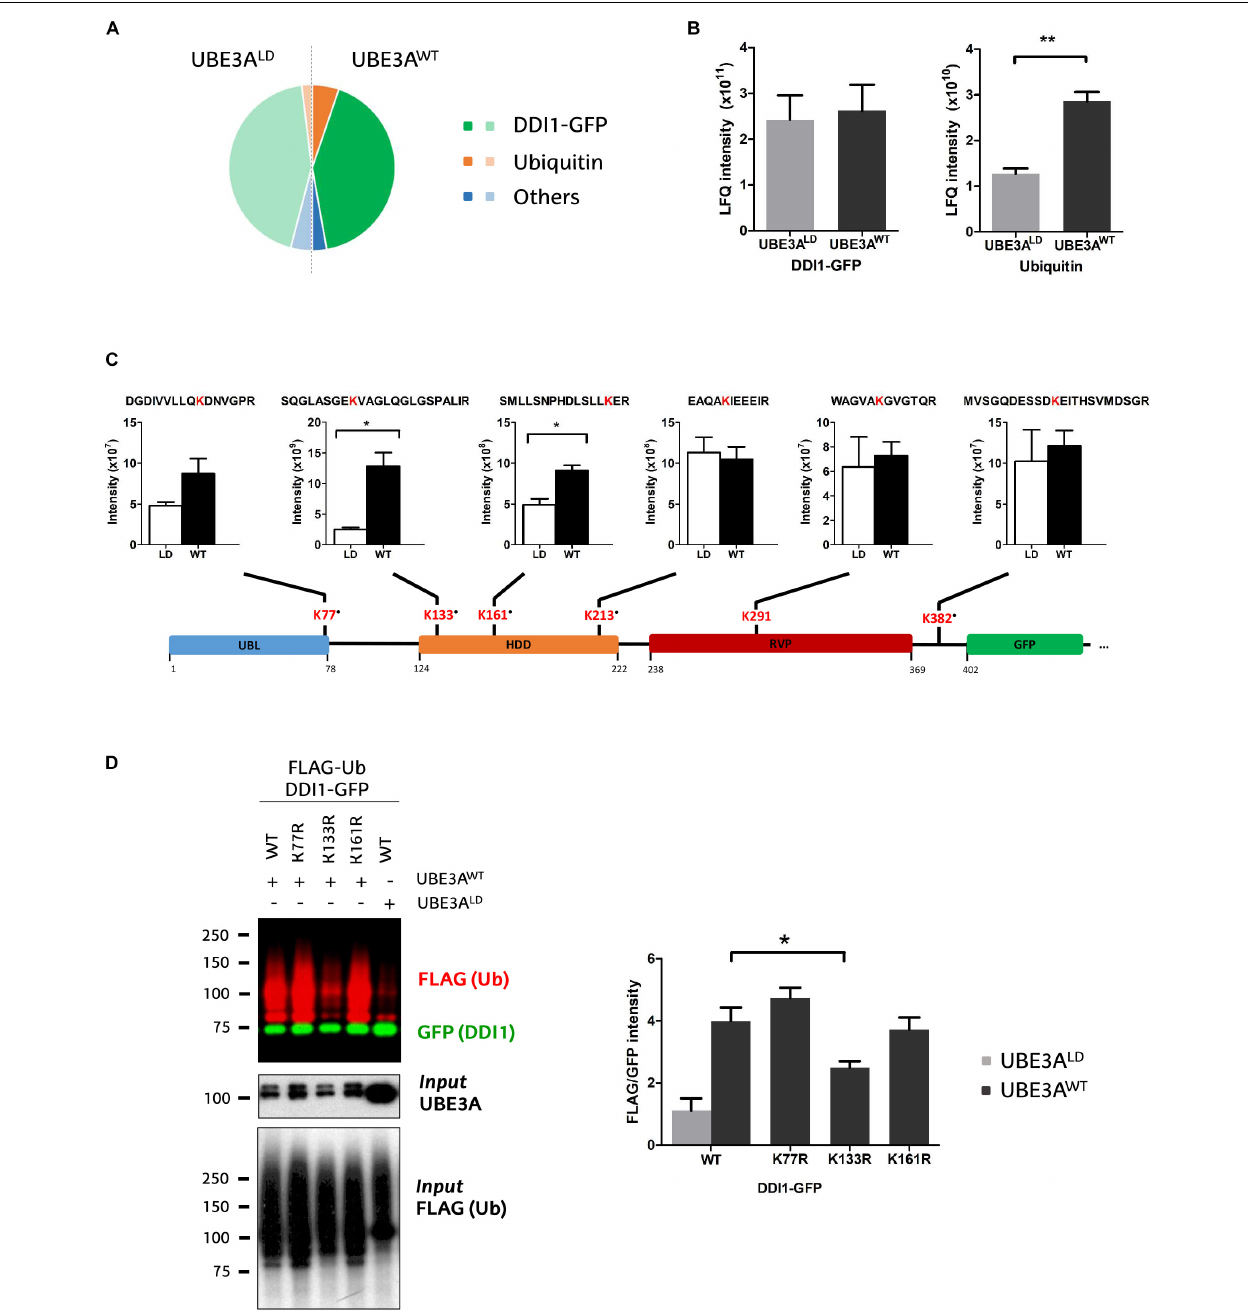
FIGURE 3 | Identification and quantification of DDI1 ubiquitination sites. (A) Relative LFQ intensity of all the proteins detected by MS demonstrate that DDI1-GFP is the most abundant protein (green) in the GFP pull-down samples, followed by ubiquitin (orange). 287 more proteins (blue) were identified with marginal intensities. (B) Comparison of the intensities recorded for the two most abundant proteins in UBE3A WT and UBE3A LD reveal that whereas the levels of DDI1 detected are similar in both conditions, more ubiquitin was detected in the presence of UBE3A WT overexpression [ t -test, ∗∗ p -value < 0.05, (mean ± S.E.M., n = 3)]. (C) Schematic illustration of DDI1-GFP sequence, its domains (blue, UBL, ubiquitin-like domain; orange, HDD, helical-double domain; red, RVP, retroviral protease domain; green, GFP, GFP-tag of DDI1 protein) and the localization of the ubiquitination sites detected by mass spectrometry. Additionally, the diGly-modified peptides identified, within the ubiquitinated lysine marked in red, and the intensity values measured in each condition (WT, UBE3A WT and LD, UBE3A LD ) are also indicated. “ • ” indicates that the ubiquitination site is not reported in PhosphoSitePlus database. DiGly peptides encompassing K133 and K161 were statistically more abundant upon UBE3A WT overexpression [ t -test, ∗ p -value < 0.05, (mean ± S.E.M., n = 3)]. (D) UBE3A-dependent ubiquitination of three distinct DDI1-GFP mutants (K77R, K133R, or K161R) was monitored by western blot after isolating by GFP-pulldown. In red it is illustrated the ubiquitination pattern of DDI1, and in green the unmodified version of DDI1-GFP. Quantification and statistical analysis of the ubiquitination was performed with Image-J after normalizing FLAG intensities to GFP levels. Mutation on DDI1 lysine 133 significantly [one-way ANOVA, ∗ p -value < 0.05, (mean ± S.E.M., n = 3)] abolishes its ubiquitination by UBE3A WT .